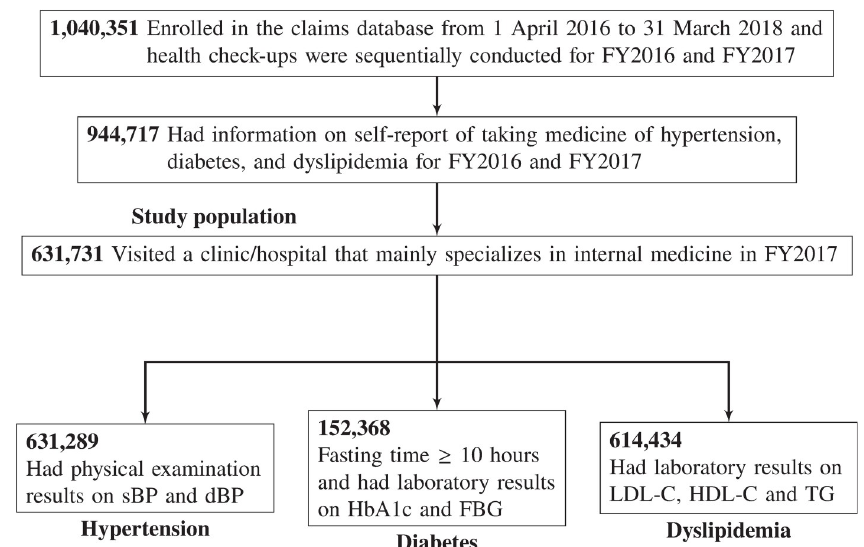
Fig 1. Flowchart of inclusion and exclusion of study participants. Abbreviations : dBP, diastolic blood pressure; FBG, fasting blood glucose; FY, fiscal year; HbA1c, hemoglobin A1c; HDL-C, high-density lipoprotein cholesterol; LDL-C, low-density lipoprotein cholesterol; sBP, systolic blood pressure; TG, triglyceride.